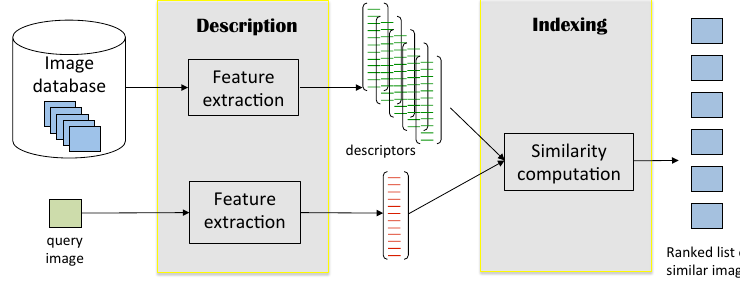
Figure 1. A CBIR system